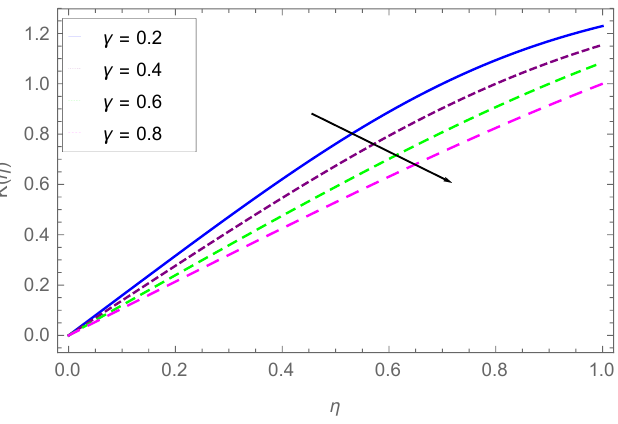
Figure 4. Plot displaying K ( η ) dependence on γ . The influence of γ on the induced flow in the y-direction is displayed in Figure 5.